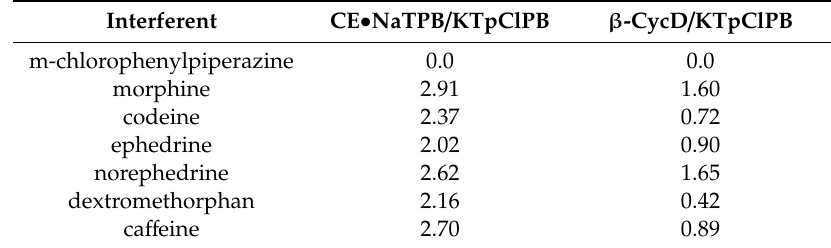
Table 3. Potentiometric selectivity coe ffi cients membrane based sensors (MPM).